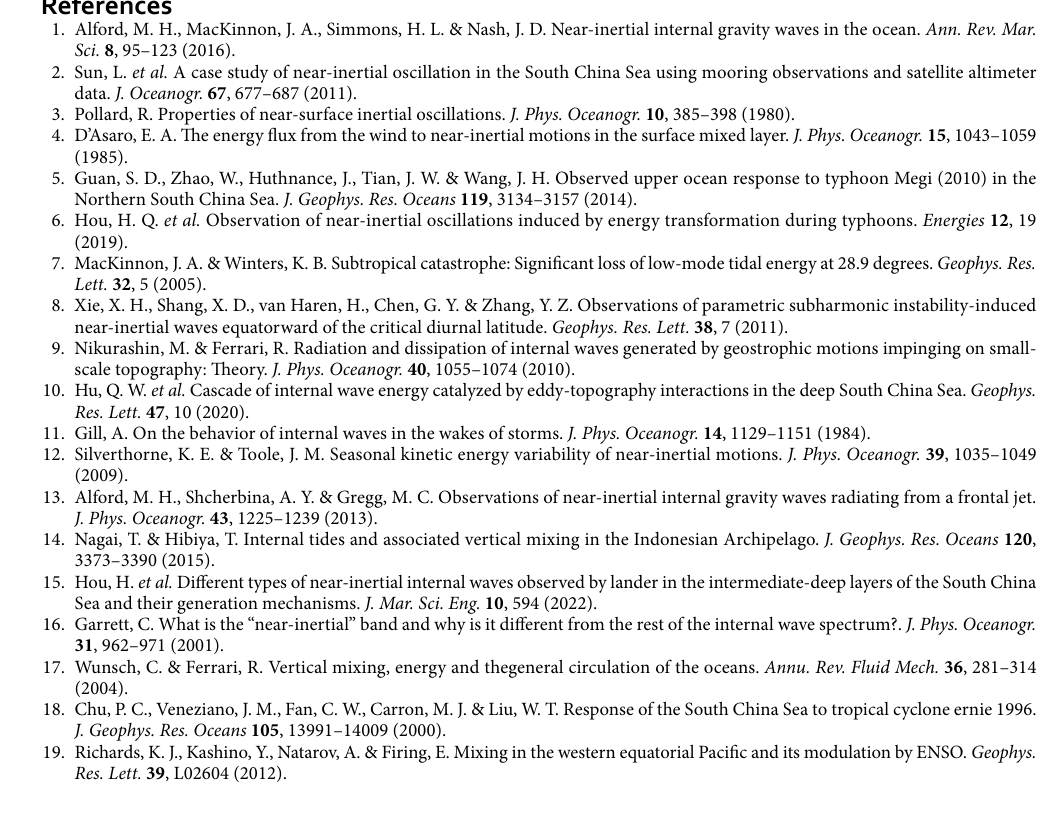
The typhoon best track dataset obtained through the China Typhoon Network (tcdata.typhoon.org.cn, accessed on 21 March 2021).